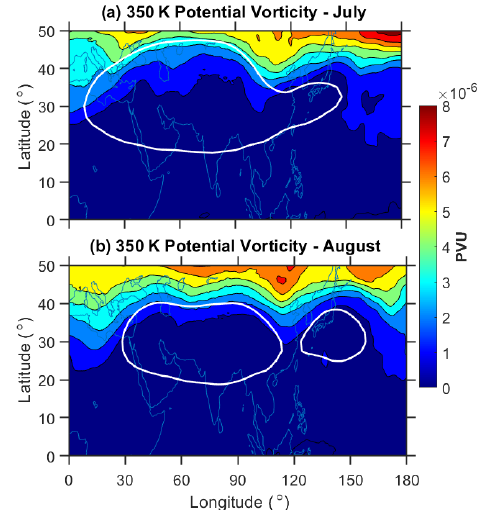
Figure 5. ERA-Interim-observed spatial distribution of potential vorticity (PV) on a 350K isentropic surface in potential vorticity units (PVUs; 1PVU = 10 − 6 Km 2 kg − 1 s − 1 ): (a) monthly mean of July and (b) monthly mean of August 2015. The solid white con- tour lines represent the ASMA region at 100hPa (16.75km GPH